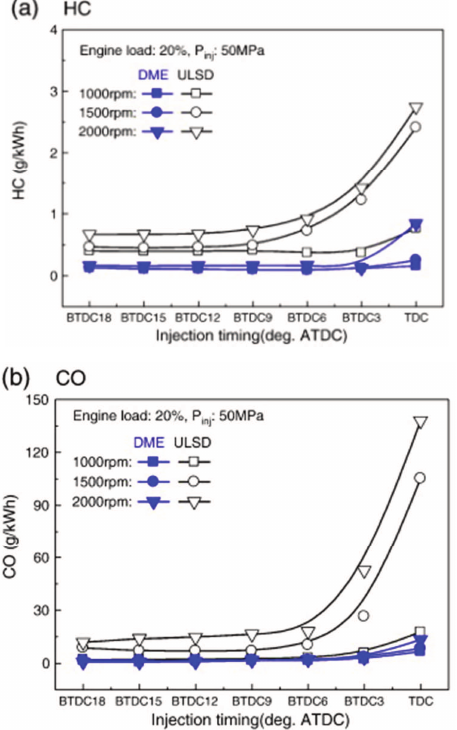
Fig. 7. Comparison of the emission of HC and CO for combustion of DME and diesel fuel